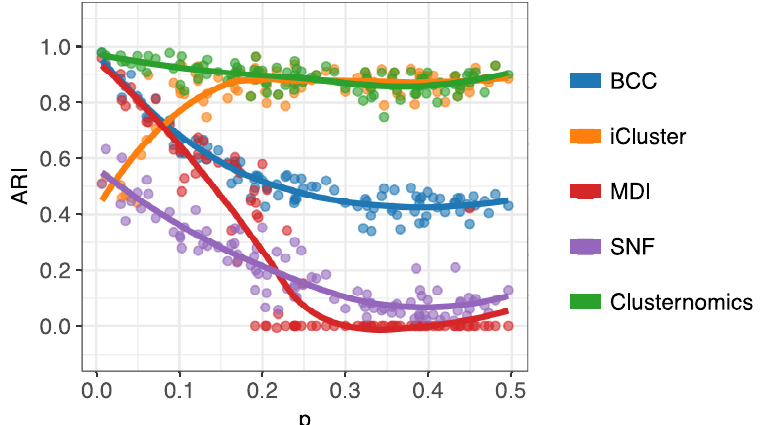
Fig 3. ARI comparing global clustering of simulated datasetsfor varying values of p (see Fig 2). Each point corresponds to the correspondingalgorithmappliedto one dataset, the plot shows also the loess curve for each method. Higher values correspondto better agreementbetweenthe estimated cluster assignments and the true cluster membership.